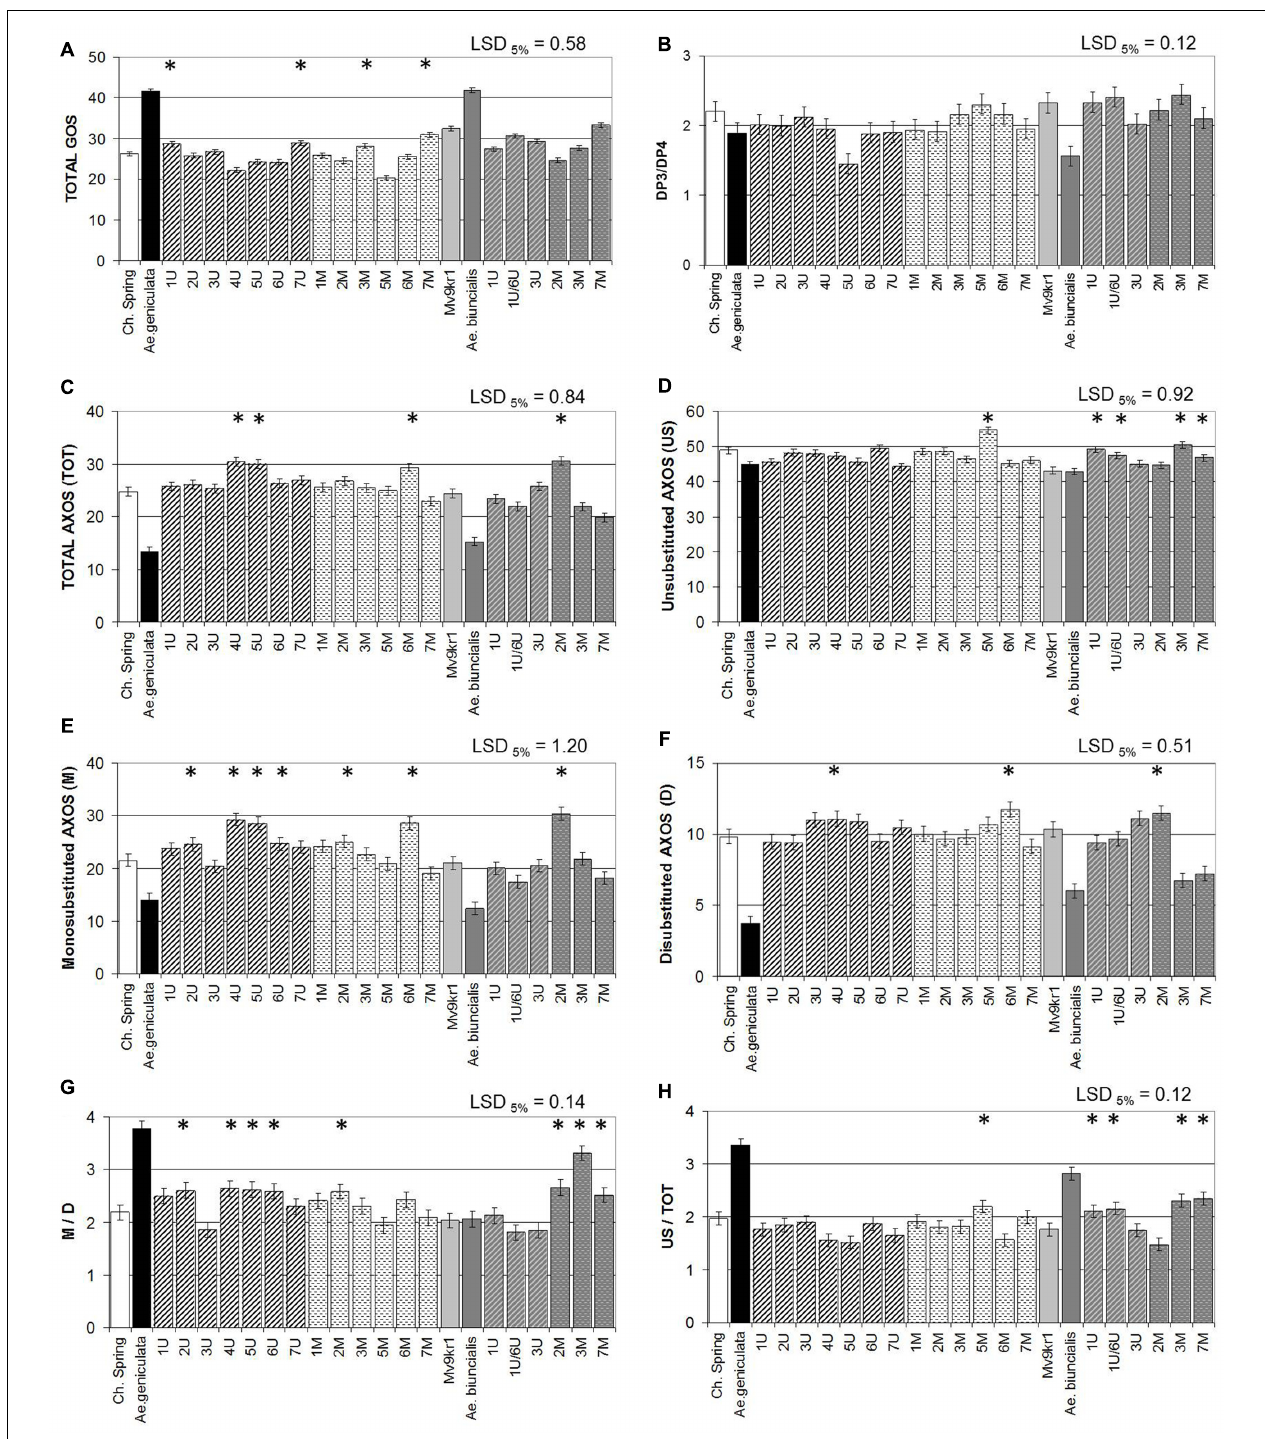
FIGURE 5 | Quantity of arabinoxylan units in mature grains of two lines of bread wheat (cv. Chinese Spring and Mv9kr1 line), two Aegilops species ( Ae. geniculata and Ae. biuncialis ), and wheat– Aegilops chromosome addition lines after enzymatic fingerprinting. (A) Quantity of β -glucan units after enzymatic fingerprinting, (B) ratio of DP3 to DP4 units, (C) TOT-AXOS, (D) unsubstituted AXOS (US), (E) monosubstituted AXOS (M), (F) disubstituted AXOS (D), (G) M/D ratio, (H) US/TOT ratio. The amounts of unsubstituted, monosubstituted, and disubstituted xylose residues in the AXOS are derived from the AXOS peak areas, calculated as (M) = (XA 3 XX) + 2(XA 3 A 3 XX) + 2(XA 3 XA 3 XX) + (XA 3 A 2 + 3 X) + (XA 3 XA 2 + 3 XX), (D) = (XA 2 + 3 XX) + (XA 3 A 2 + 3 X) + (XA 3 XA 2 + 3 XX), (US) = X + XX + XXX, and (TOT) = X + XX + XXX + XA 3 XX + XA 3 A 3 XX + XA 3 XA 3 XX + (XA 2 + 3 XX) + (XA 3 A 2 + 3 XX) + (XA 3 XA 2 + 3 XX) AXOS, arabinoxylan oligosaccharide; DP, degree of polymerization; LSD, least significant difference; TOT, total. ∗ Significantly higher than the wheat ( T. aestivum ) control.